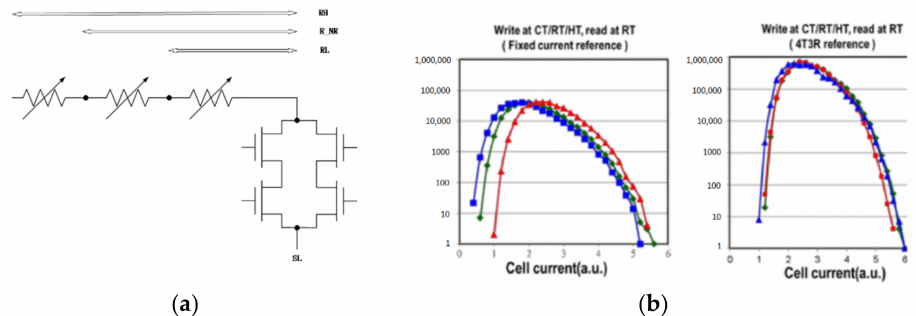
Figure 5. ( a ) 4T3R scheme; ( b ) The cell current distribution, the number of cell at different cell current [78].